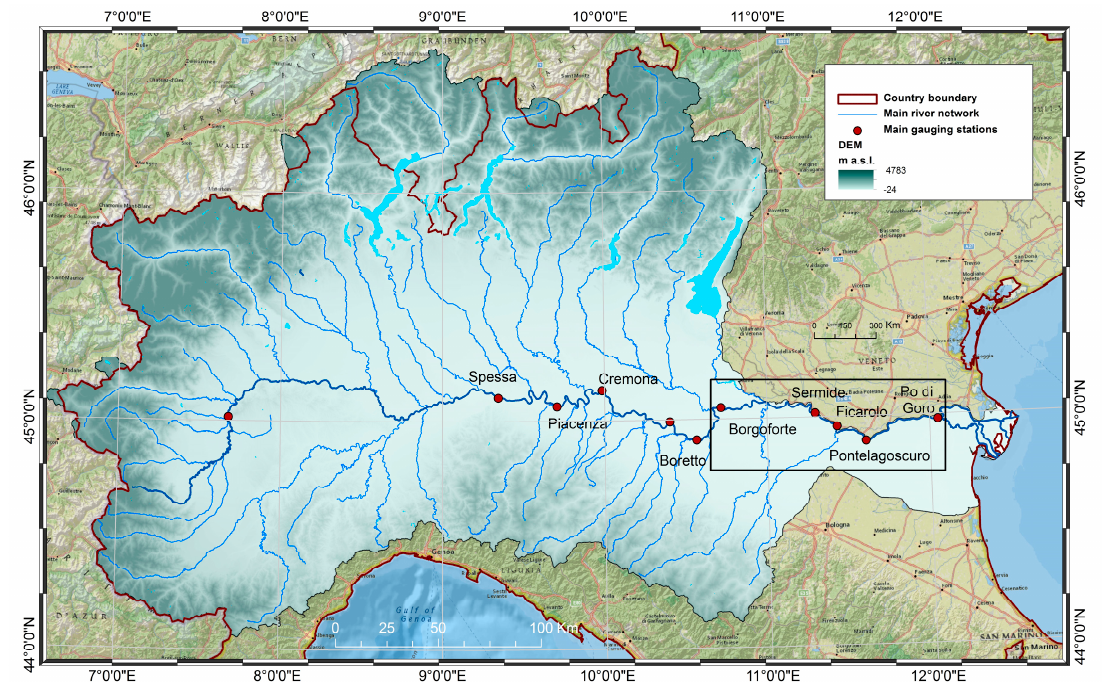
Figure 1. Po River Basin, showing the main river network, gauging stations (red dots) and the river reach of interest (black box).